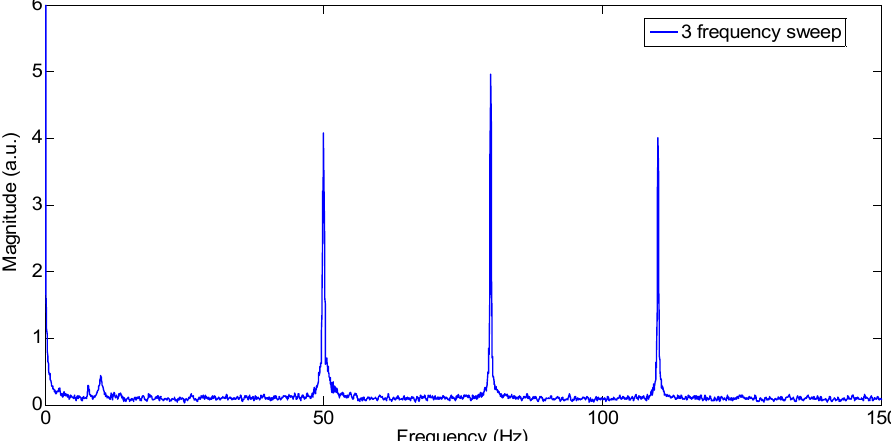
Figure 5. FFT (Fast Fourier Transform) data of consecutively swept frequencies at 50 Hz, 80 Hz and 110 Hz with random number of samples. Small peak observed near 7 Hz due to natural oscillations.